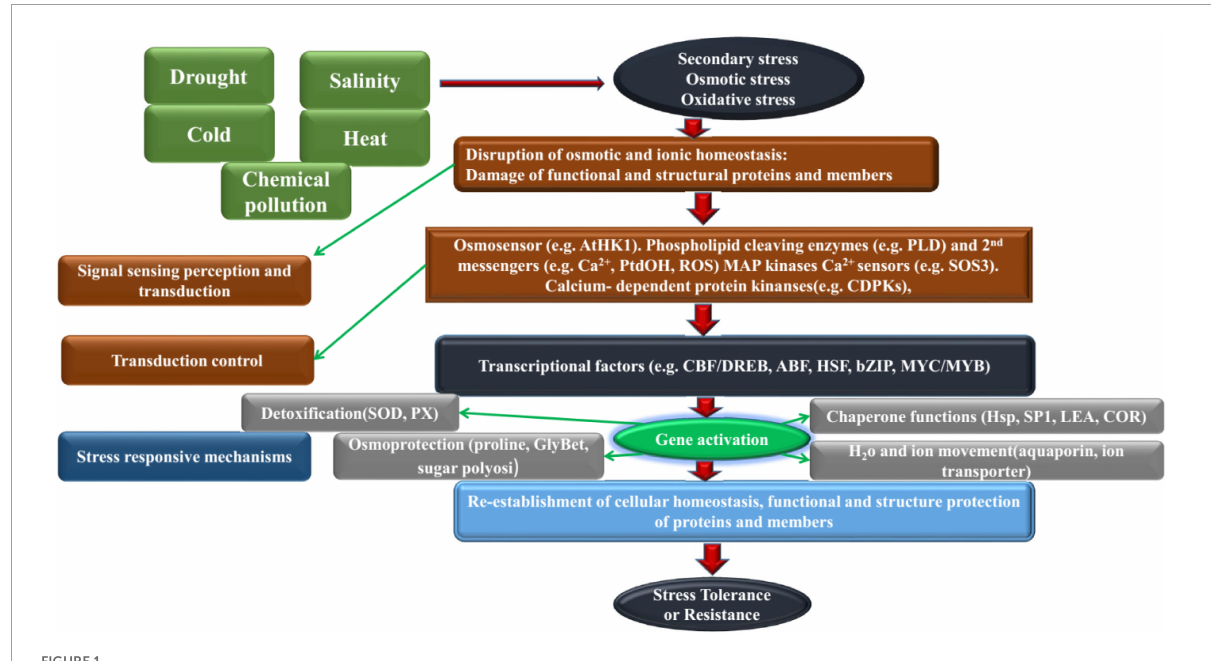
FIGURE1 The complexity of plant response to adversity stress.